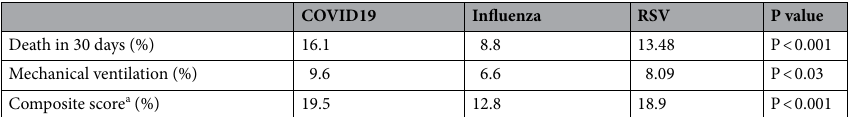
Table 3. Components of adverse outcomes score of patients presenting with viral infections. a Composite score considered positive if one of the following criteria were met: mortality, defined as death at 30 days or need for mechanical ventilation. COVID-19 coronavirus disease 2019, RSV respiratory syncytial virus, LOS length of stay.